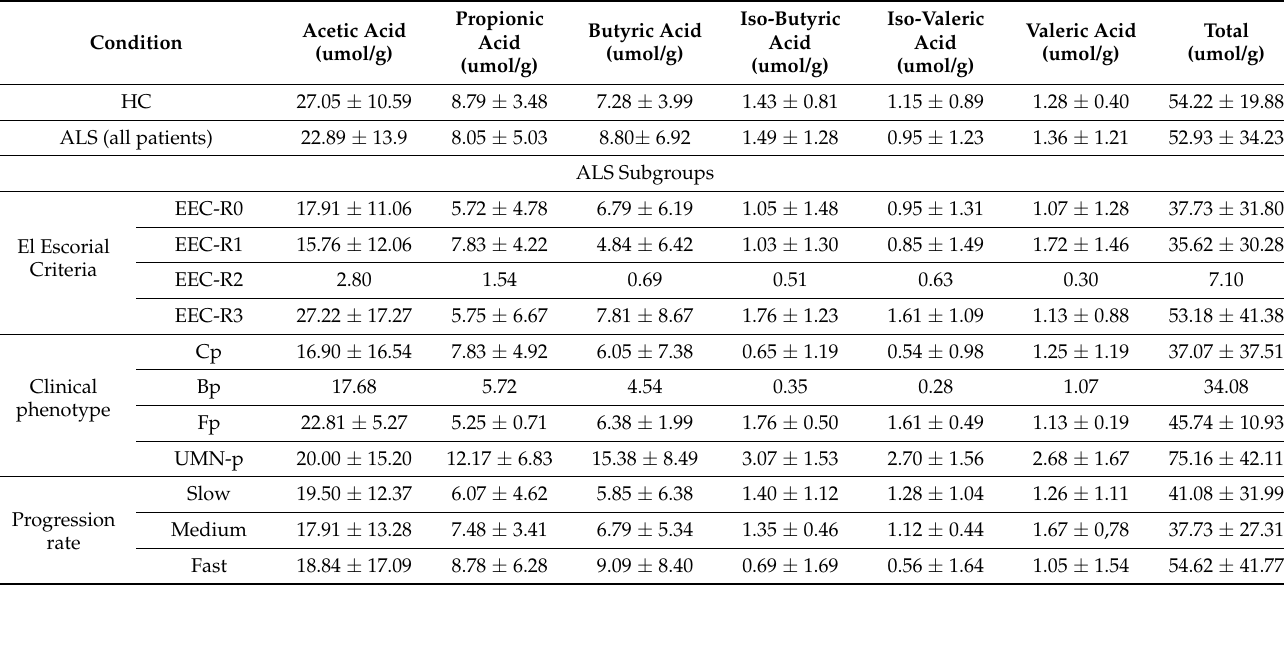
Table 2. Mean ± standard deviation of each short chain fatty acid concentration in patients and healthy controls. ALS = amy- otrophic lateral sclerosis. HC = healthy controls. EEC = EL Escorial Criteria; EEC-R0 = definite; EEC-R1 = clinically probable; EEC-R2 = probable-laboratory-supported; EEC-R3 = possible. Bp = Bulbar phenotype; Cp = Classic phenotype; Fp = Flail arm/leg phenotype; UMNp = Upper Motor Neuron predominant phenotypes.